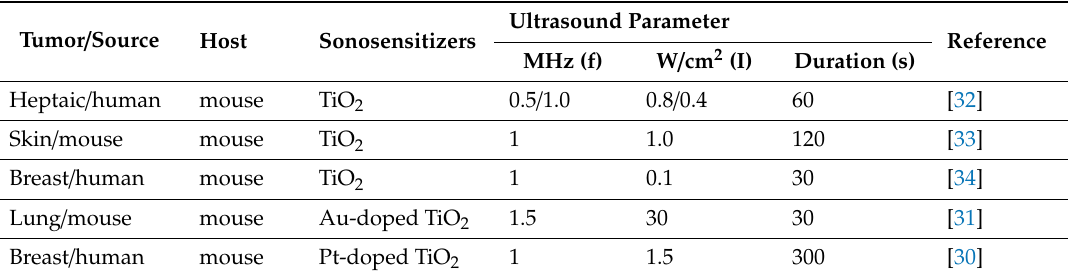
Table 1. The sonosensitizers and the matched ultrasound